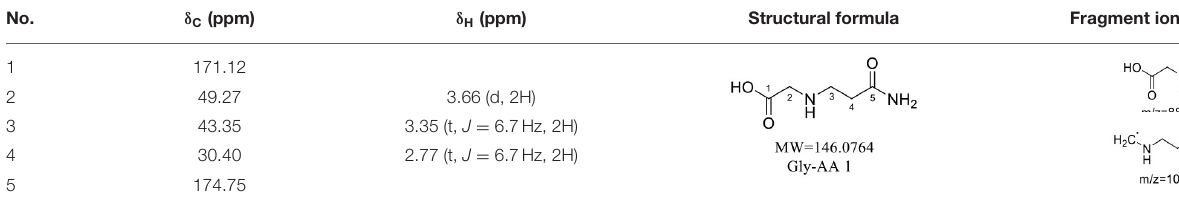
TABLE 8 | NMR spectra data of Gly-AA 1 measured in D 2 O.